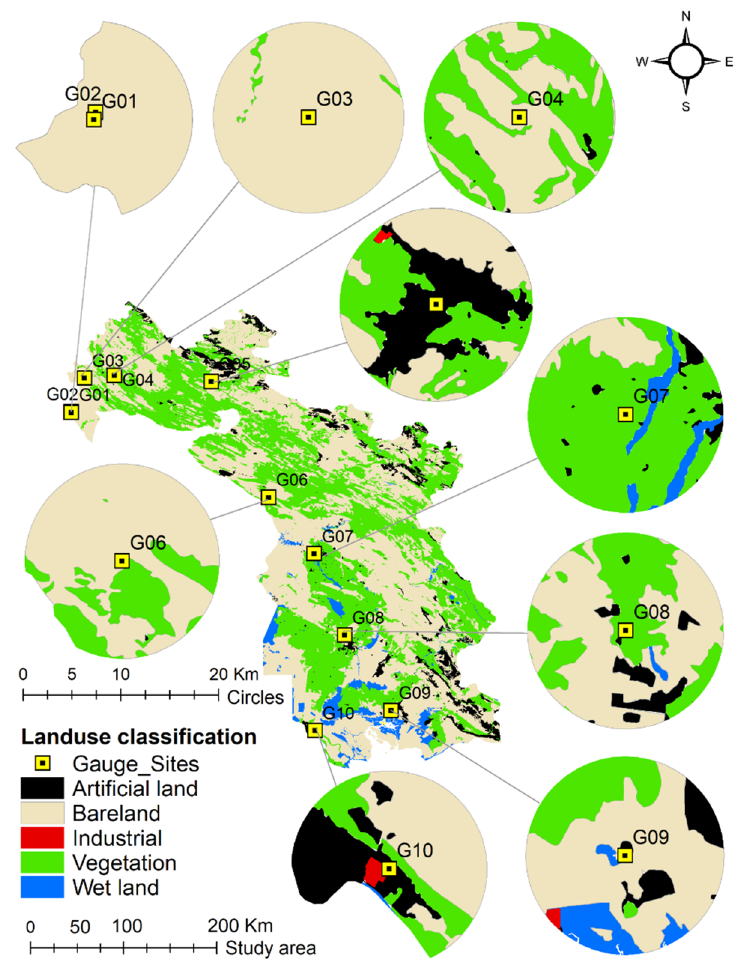
Figure 3. Circle centered at each gauge site representing the LULC within a radius of 10 km. A given circle centered (with a radius of 10 km) at each gauge site (G01–G10) represents the spatial pattern of the LULC. This analysis represents the whole area with respect to each sampler at the gauge site.